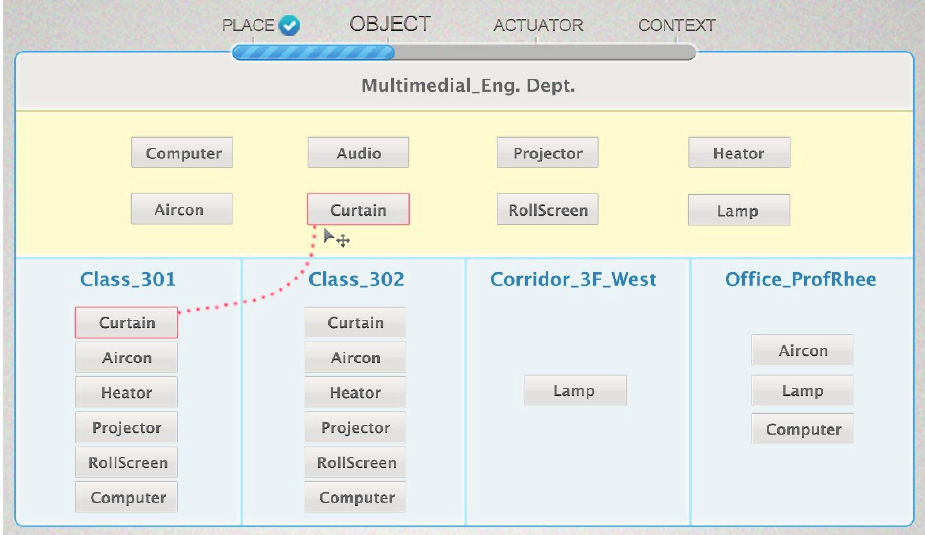
Figure 15. Web-based service modeling UI (Phase 2: object